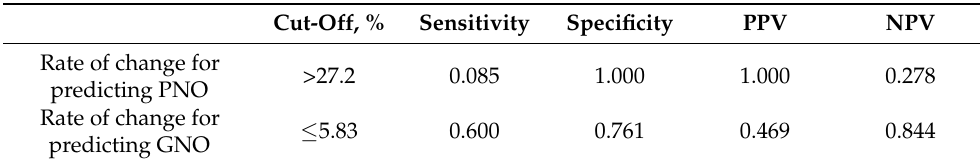
Figure 3. Receiver operator curve for predicting poor neurologic outcome using rate of optic nerve sheath diameter change. AUC = 0.64 (95% confidence interval = 0.53–0.73). Table 4. Cut-off and diagnostic value of optic nerve sheath diameter change for predicting good and poor neurologic